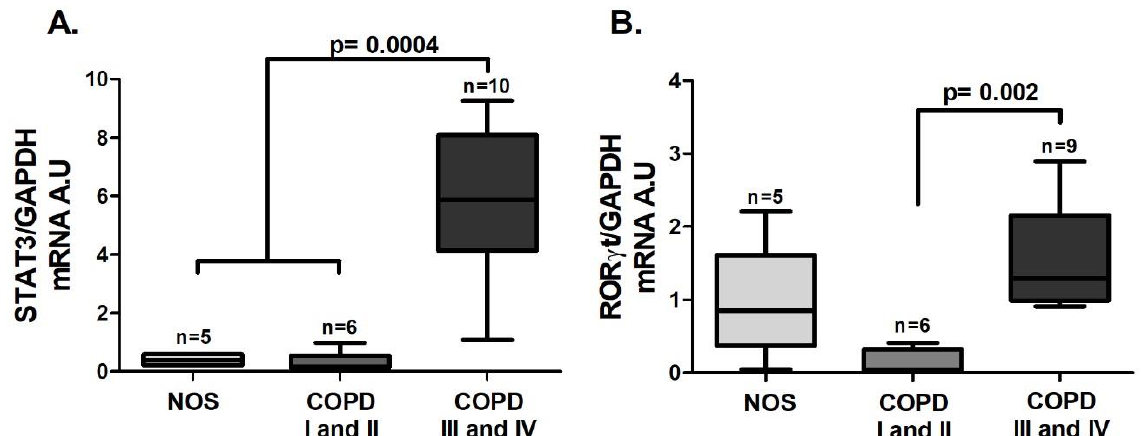
Figure 3. Th17 transcription factors in the systemic response. Th17 transcription factors gene expression in white blood cells: ( A ) increased STAT3 gene expression ( p = 0.0004, Kruskal – Wallis test) in the COPD III and IV group compared to the other groups; ( B ) increased RORγt gene expression ( p = 0.002, Kruskal – Wallis test) in the COPD III and IV group compared to the COPD I and II group. The data are expressed as the median and interquartile range. A.U: Arbitrary Units.